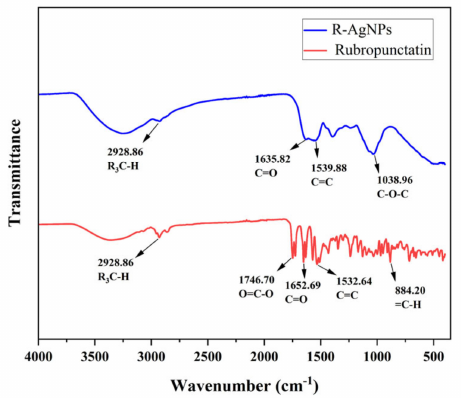
Figure 5. FT-IR spectra of R-AgNPs and